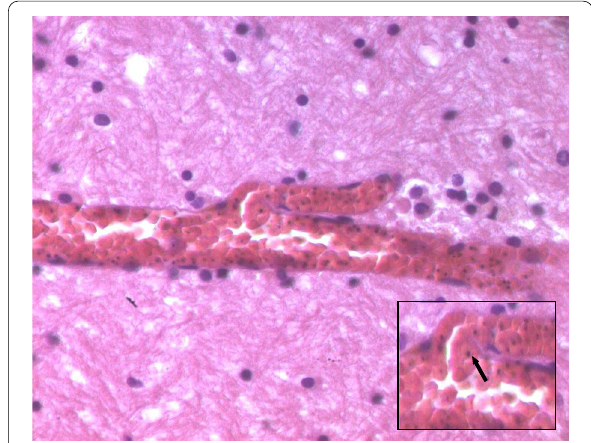
Fig. 3 Histology findings showing congested brain capillary containing numerous parasitized erythrocytes (trophozoites), with intraerythrocytic malaria pigment appearing as small black dots (enlarged image with arrow). Hematoxylin and eosin,